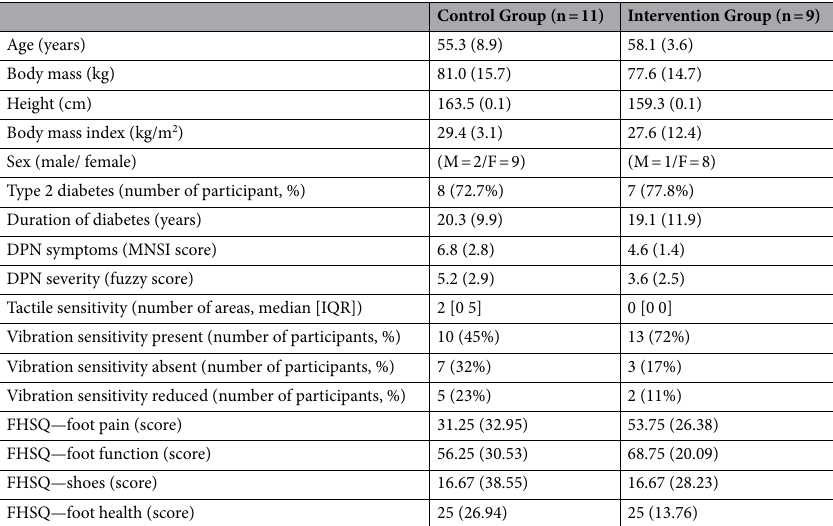
Table 1. Baseline participant’s characteristics from the Control and Intervention groups. Data are presented as mean (SD) or as n or %. FHSQ Foot Health Status Questionnaire, DPN diabetic peripheral neuropathy, MNSI Michigan Neuropathy Screening